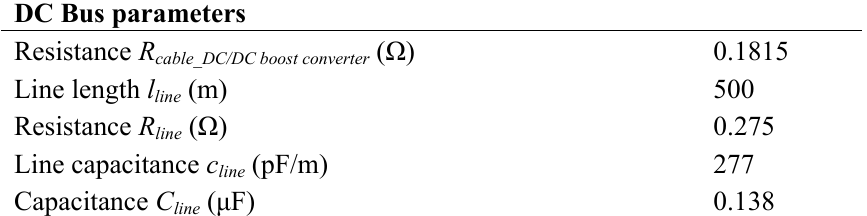
Figure 7. Variation of DC voltage.